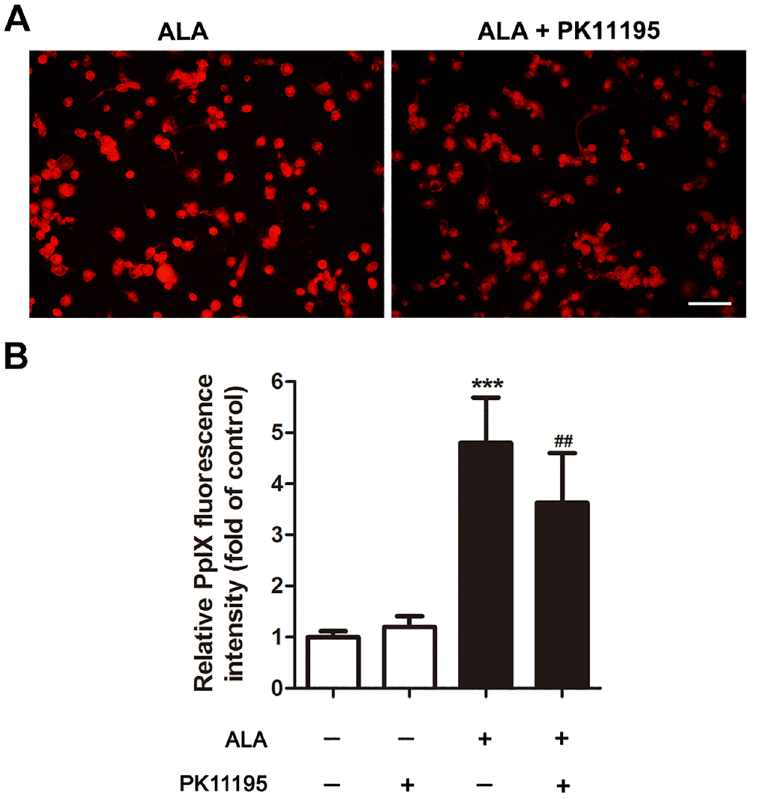
Fig 1. Effects of PK 11195 on endogenous ALA-PpIX accumulation. THP-1 macrophages were incubated for 3 hours with 5-aminolevulinic acid (ALA) with or without PK 11195. (A) Red fluorescence of intracellular PpIX was identified by fluorescence microscope. Scar bar: 0.1 mm. (B) Fluorescence intensity of PpIX was measured by fluorescence microplate reader. (cid:3)(cid:3)(cid:3) P < 0.001 compared to no treatment group, ## P < 0.01 compared to ALA treated